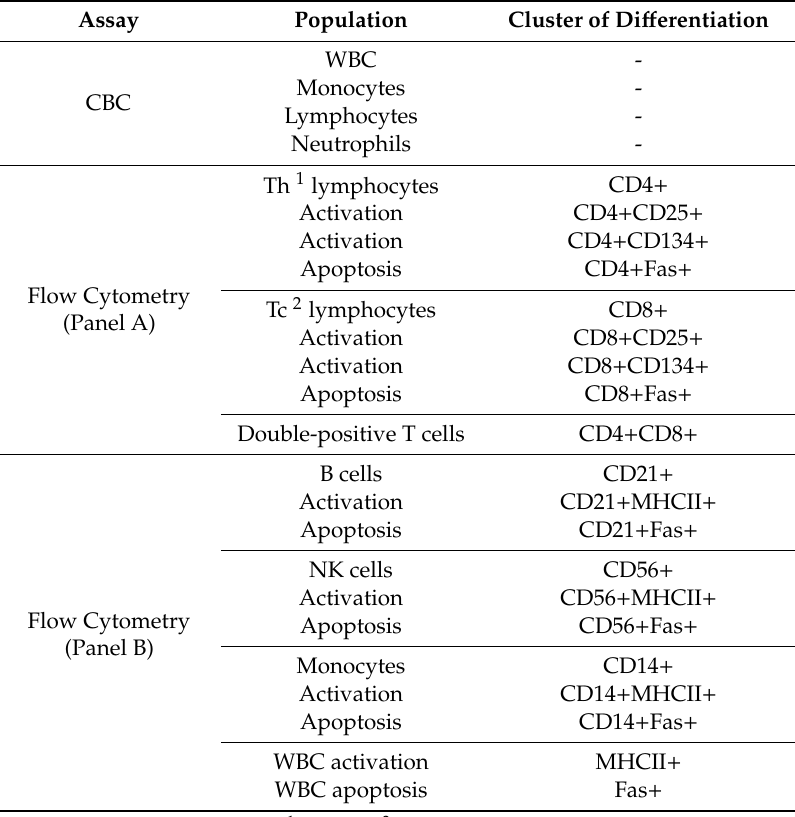
Table 1. White blood cell (WBC) populations assayed for peripheral blood mononuclear cell (PBMC) phenotype analysis. Assay Population Cluster of Di ff erentiation